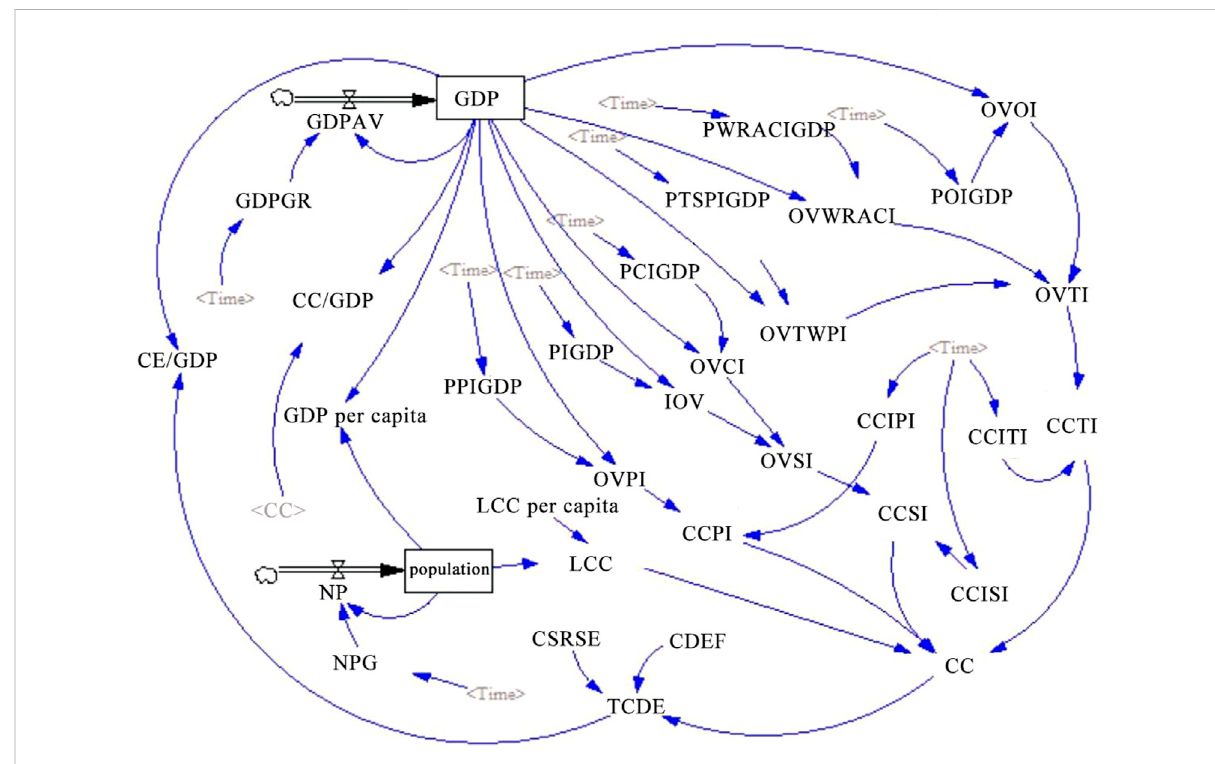
FIGURE 2 The dynamic fl owchart of coal consumption system.